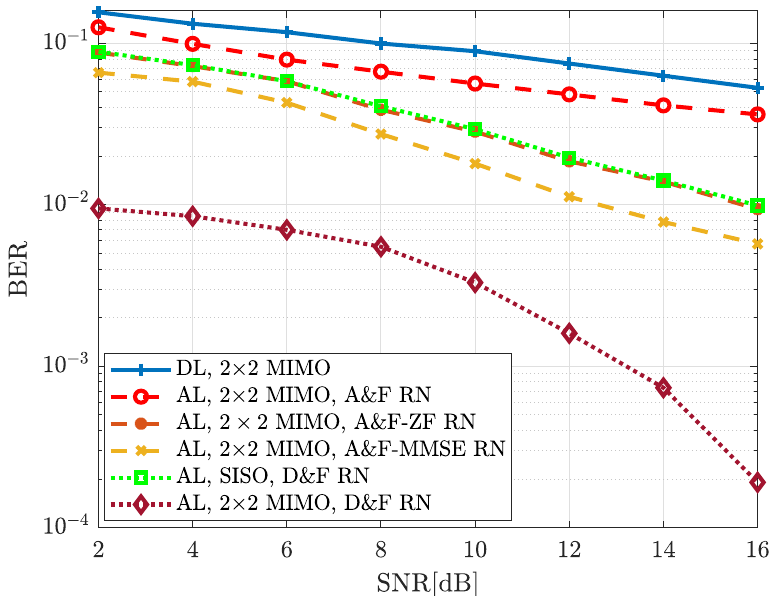
Figure 13. BER performance of the implemented RNCS, in comparison with a conventional MIMO